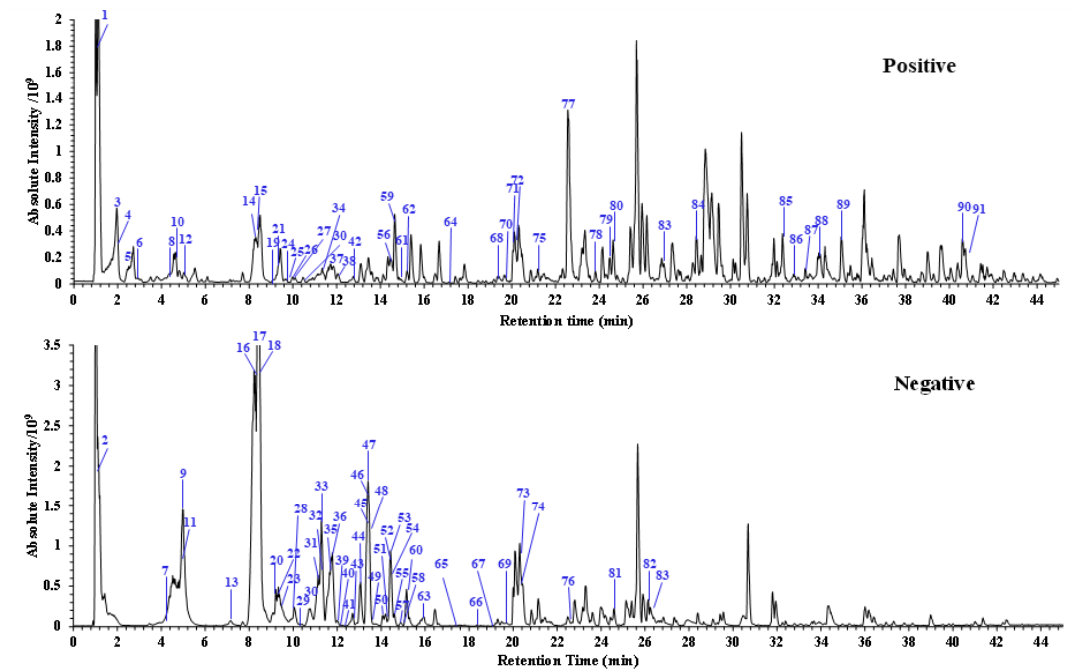
Figure 1. The total ion chromatograms of the tubers of G. conopsea , extracted by ultra-high performance liquid chromatography combined with an Orbitrap mass spectrometer (UPLC–Orbitrap–MS / MS) in positive- and negative-ion modes.